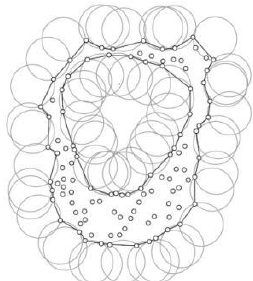
Figure 1. The priciple of Alpha Shape